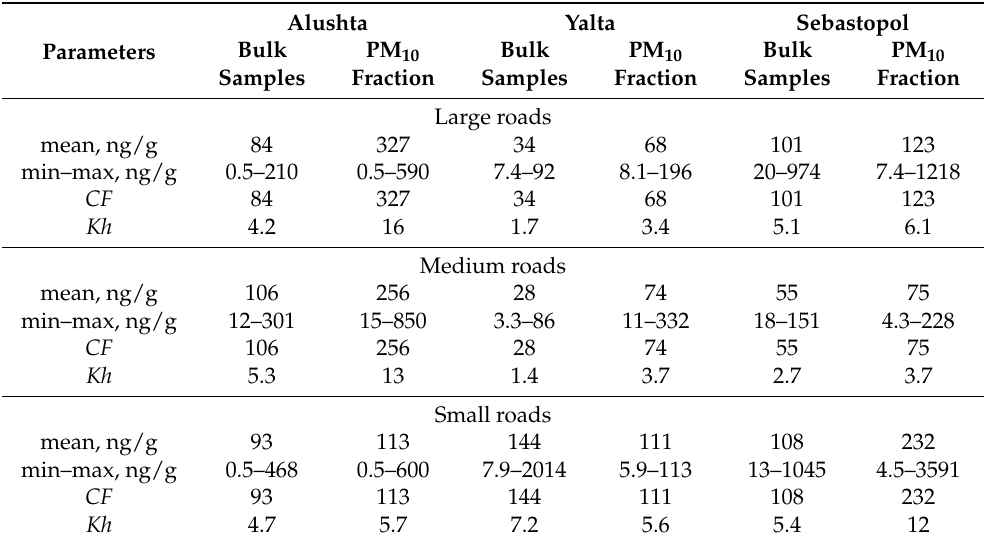
Table 2. The content of benzo(a)pyrene in the bulk samples of road dust and its PM 10 fraction and its environmental hazard in Alushta, Yalta and Sebastopol.